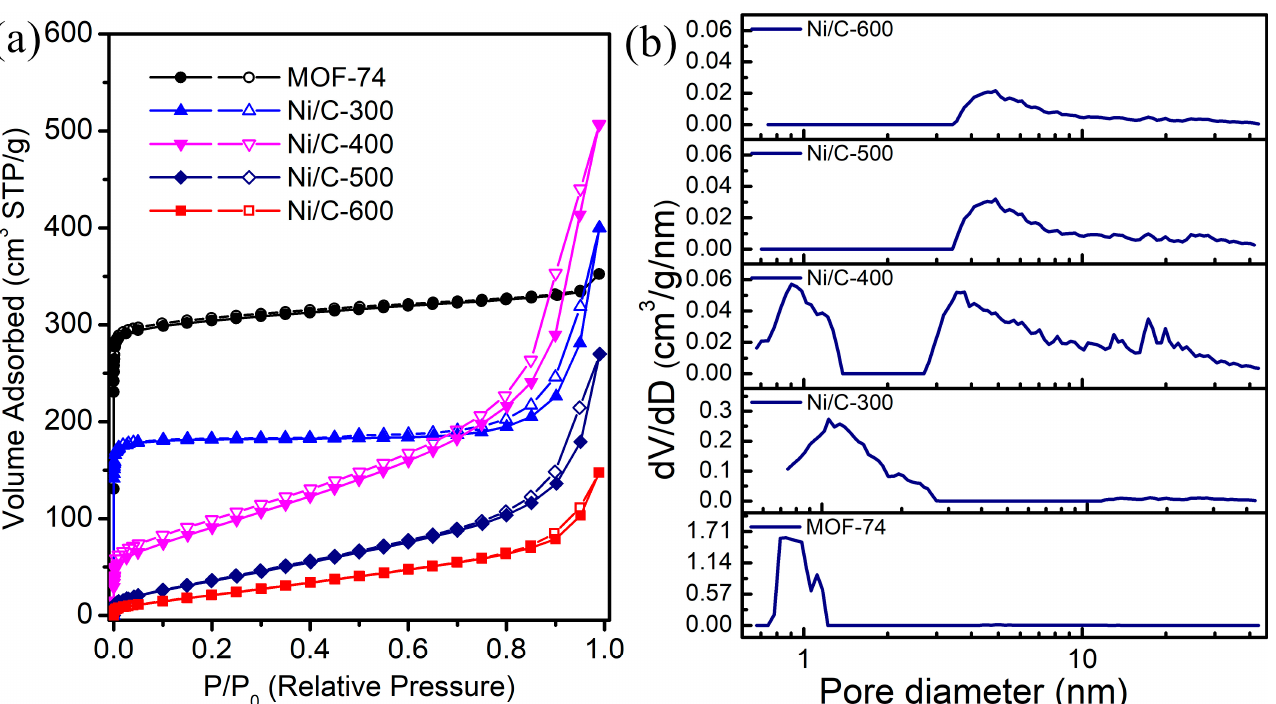
Figure 3. ( a ) N 2 adsorption − desorption isotherms and ( b ) pore size distribution of MOF-74 and derived Ni/C at different temperatures.